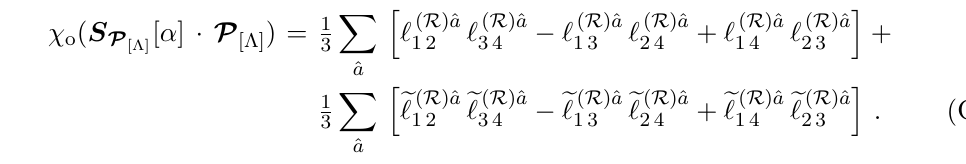
Table 16 . Non-vanishing ‘ , e ‘ , and (cid:31) o values for representation P The value of the\Kye-Oh" function when expressed in terms of the ‘ and e ‘ parameters of (2.7) takes the form